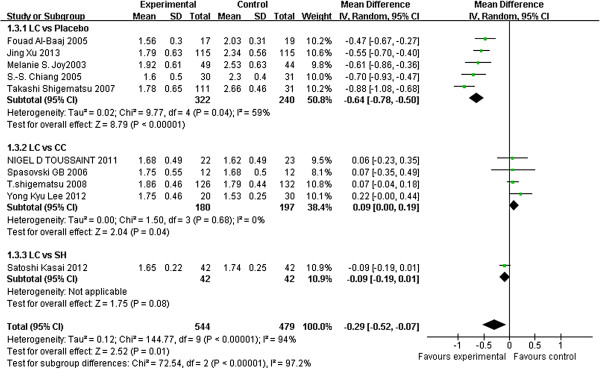
Forest plot of serum phosphate level of patients treated with LC and control therapy. Studies were identified by name of the first author and year of publication. Mean differences (MDs) were pooled using the random-effect model and shown on a scale of −1 to 1.